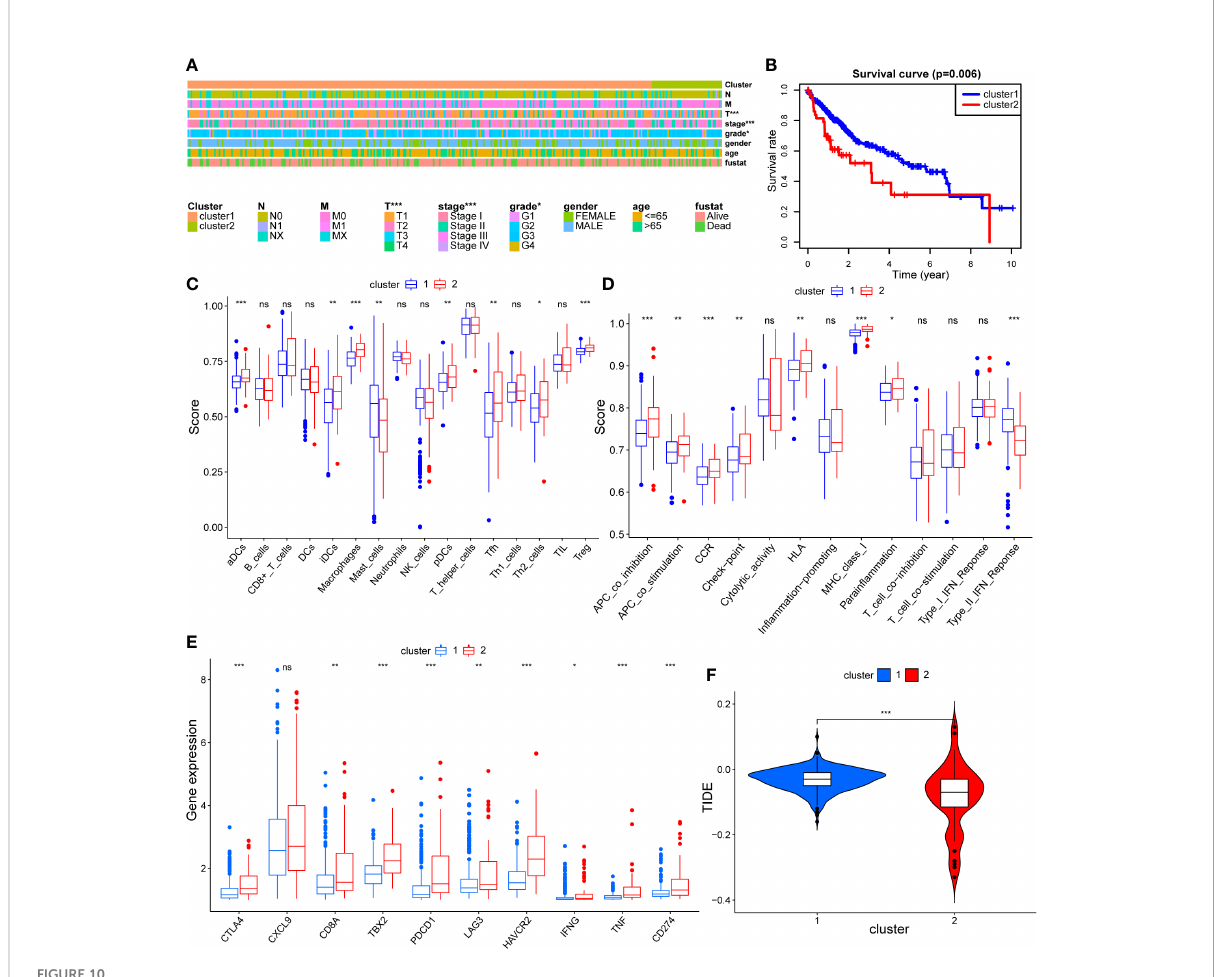
FIGURE 10 The validation of mitophagy-related HCC subtypes using mitophagy signature obtained from cell experiment. (A) A heatmap showing association between subtypes and clinical characteristics. (B) The Kaplan – Meier plot showing distinct prognosis between two subtypes. (C – E) Box plots showing the differences of in fi ltrating immunocyte abundance (C) , immune reaction activity (D) , and expression of immune- checkpoint genes (E) between two subtypes. (F) Violin plots comparing the Tumor Immune dysfunction and Exclusion (TIDE) score of each subtype. The asterisks represent the p value (* p < 0.05; ** p < 0.01; *** p < 0.001). ns, not signi fi